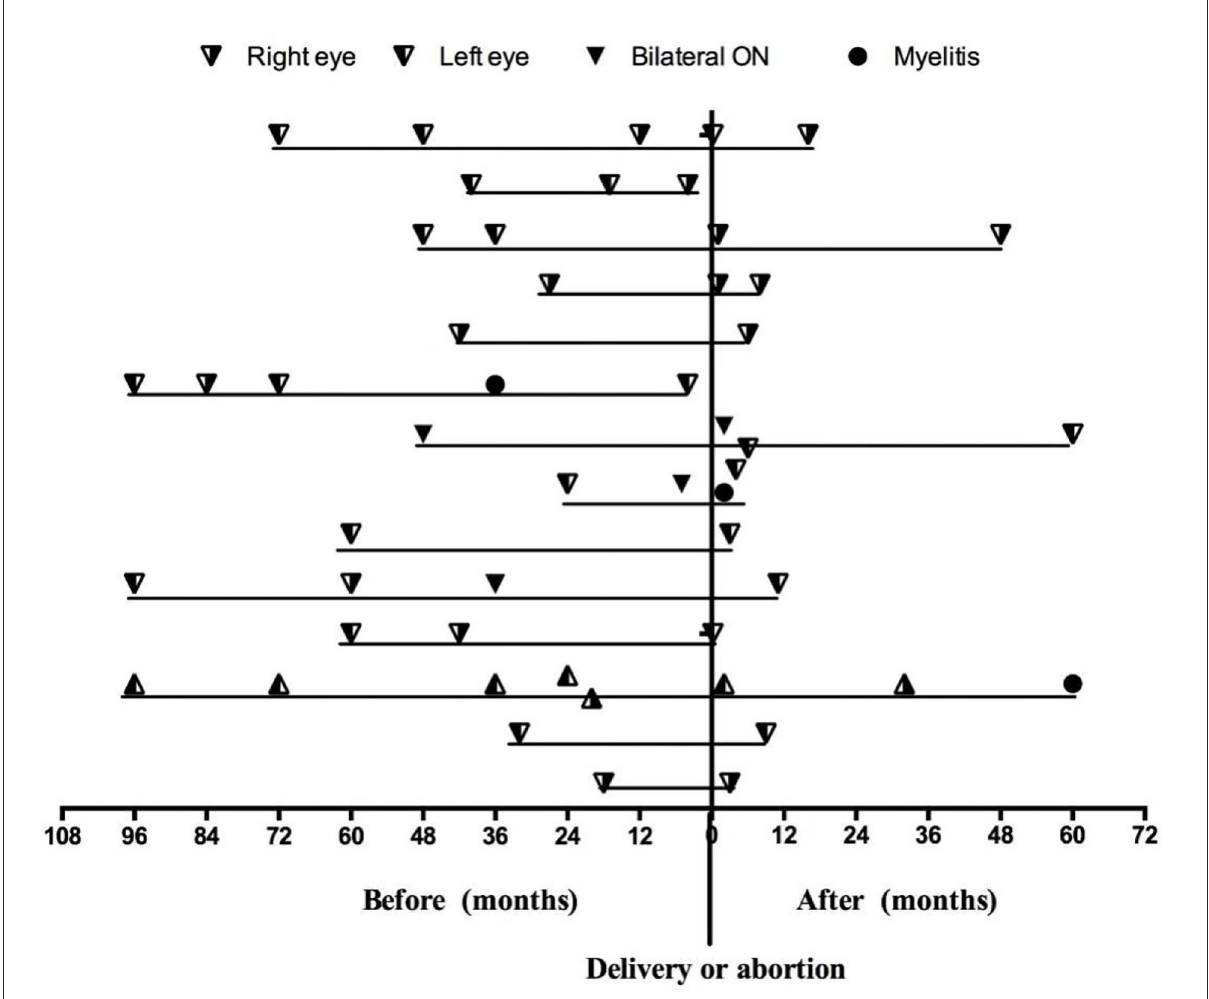
FIGURE2 The relapses throughout the disease duration for 14 patients who became pregnant after ON onset.